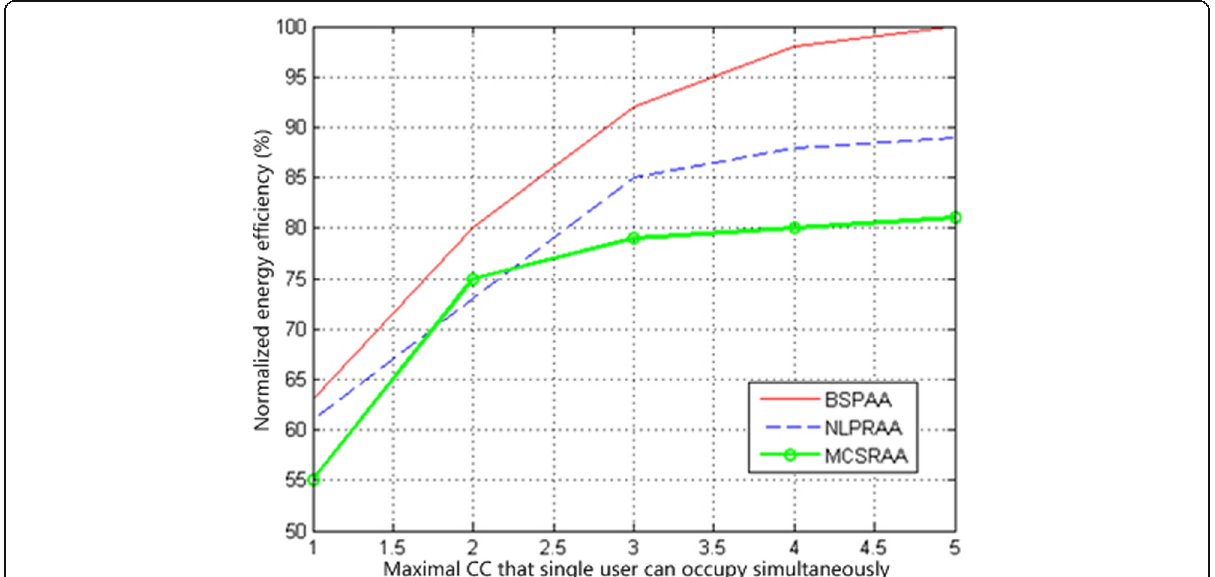
Fig. 5 System energy efficiency v.s. maximal CC that a single user can occupy